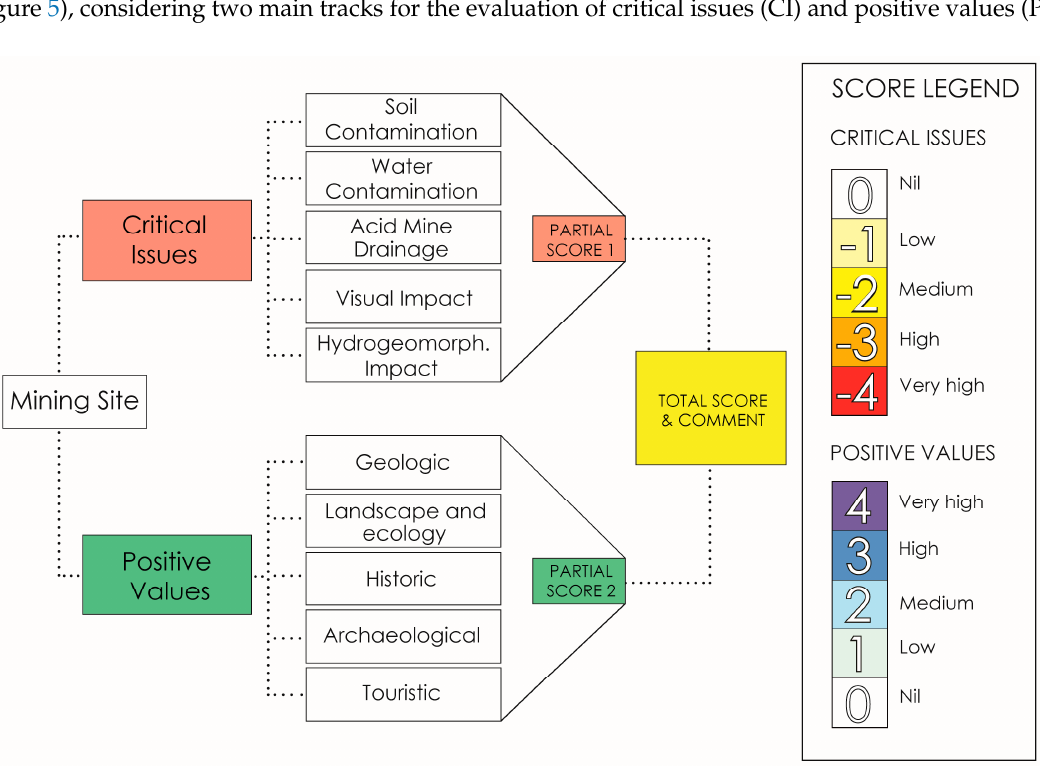
Figure 5. Flowchart for the evaluation of the critical issues and positive values of abandoned mining areas. Scores explanation for each element considered are described in the text and reported in Tables 1 and 2.